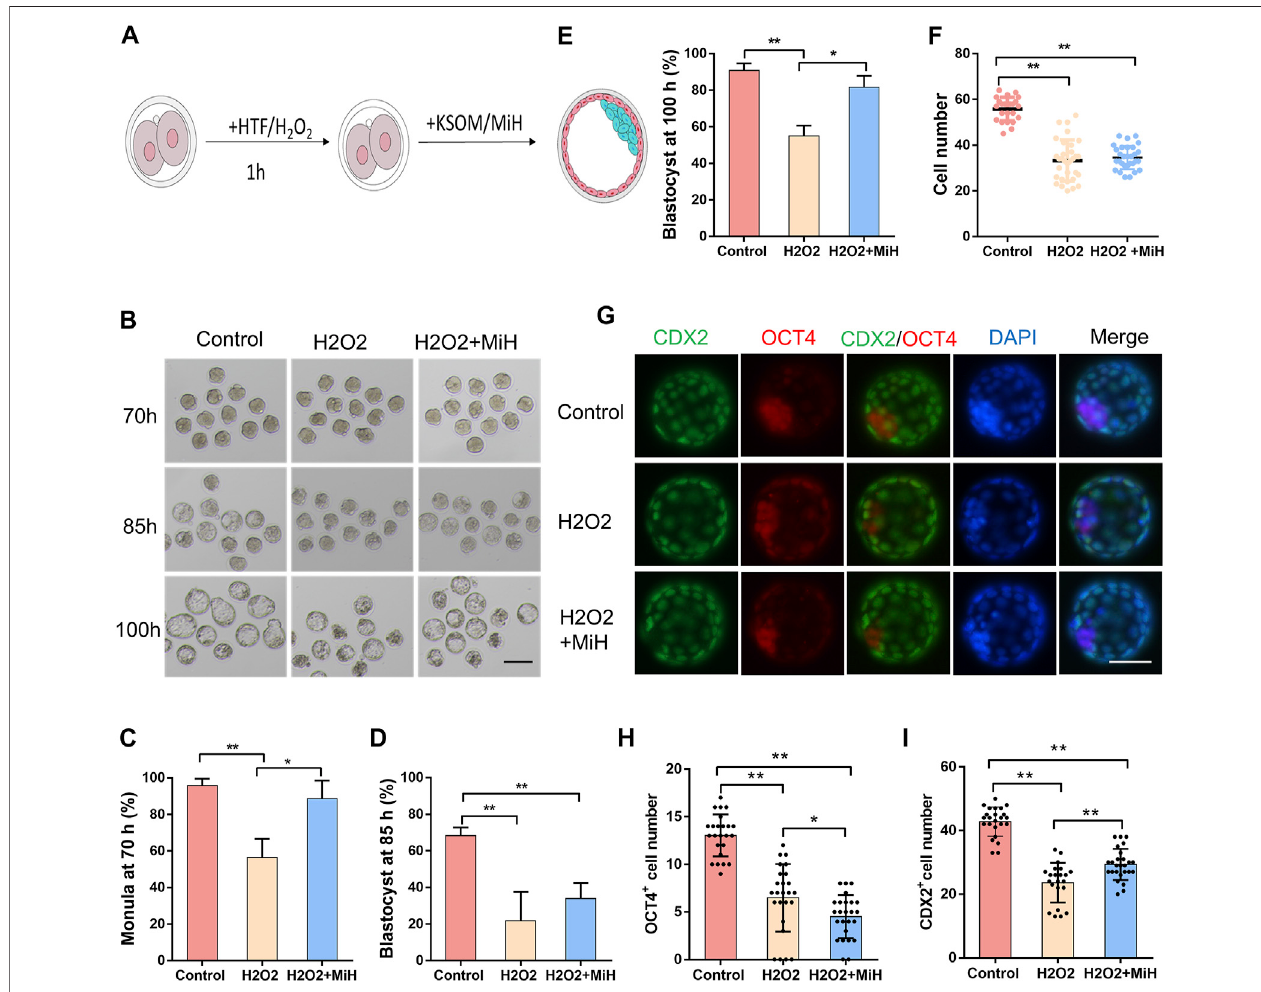
FIGURE 4 | MiH improved mouse preimplantation embryos viability against oxidative stress. (A) Main procedure of oxidative embryo model and MiH treatment assay. (B) Representative images of embryos in control and H2O2-treated groups with or without MiH at 70, 85, 100 h after fertilization. Bar (cid:1) 100 μ m. Control referred to embryos who had not suffered from H2O2 treatment and cultured under KSOM; H2O2 and H2O2+MiH referred to zygotes who were treated with 0.1 mM H2O2 for 1 h and then cultured under KSOM in the absence (H2O2) or presence of MiH (H2O2+MiH), respectively. (C – E) Morula or blastocyst formation ef fi ciencies at 70 h (C) , 85 h (D) and 100 h (E) after fertilization.44, 47,45embryos weretotally counted incontrol, H2O2- and H2O2+MiH-treated groups, respectively. (F) Comparison of cell numbers of blastocyst at 100 h (G – I) Immuno fl uorescent images of blastocysts at 100 h. CDX2 (green) and OCT4 (red) were used as markers for TE and ICM separately.Bar (cid:1) 50 μ m. N (Control) (cid:1) 26, n (H2O2) (cid:1) 34, n (H2O2+MiH) (cid:1) 31.Dataarepresented asmean ± SDinthreeindependent experiments andstudent ’ sttests are used for statistical analysis. p 0.01 < p < 0.05; pp p < 0.01; no labeling indicates no statistical signi fi